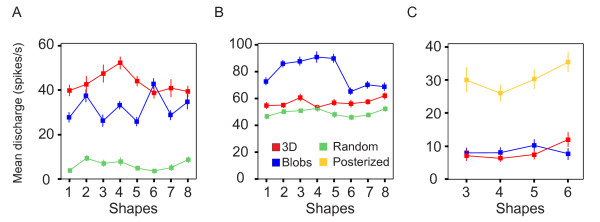
Examples of 'content' cells responses. Each plot shows the mean responses of a single neuron to each 3D shape (the 4 different illumination directions are pooled together). Neurons preferring 3D stimuli (A), Blobs stimuli (B) and Posterized stimuli (C) are plotted separately. Colored curves correspond to the types of stimuli (see legend). Error bars correspond to standard error of the mean.